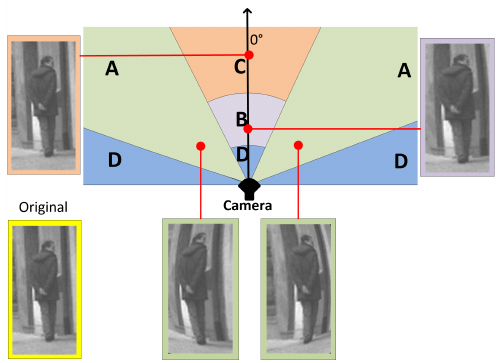
Figure 5. Artificial distorted images and their corresponding positions on the fisheye camera’s